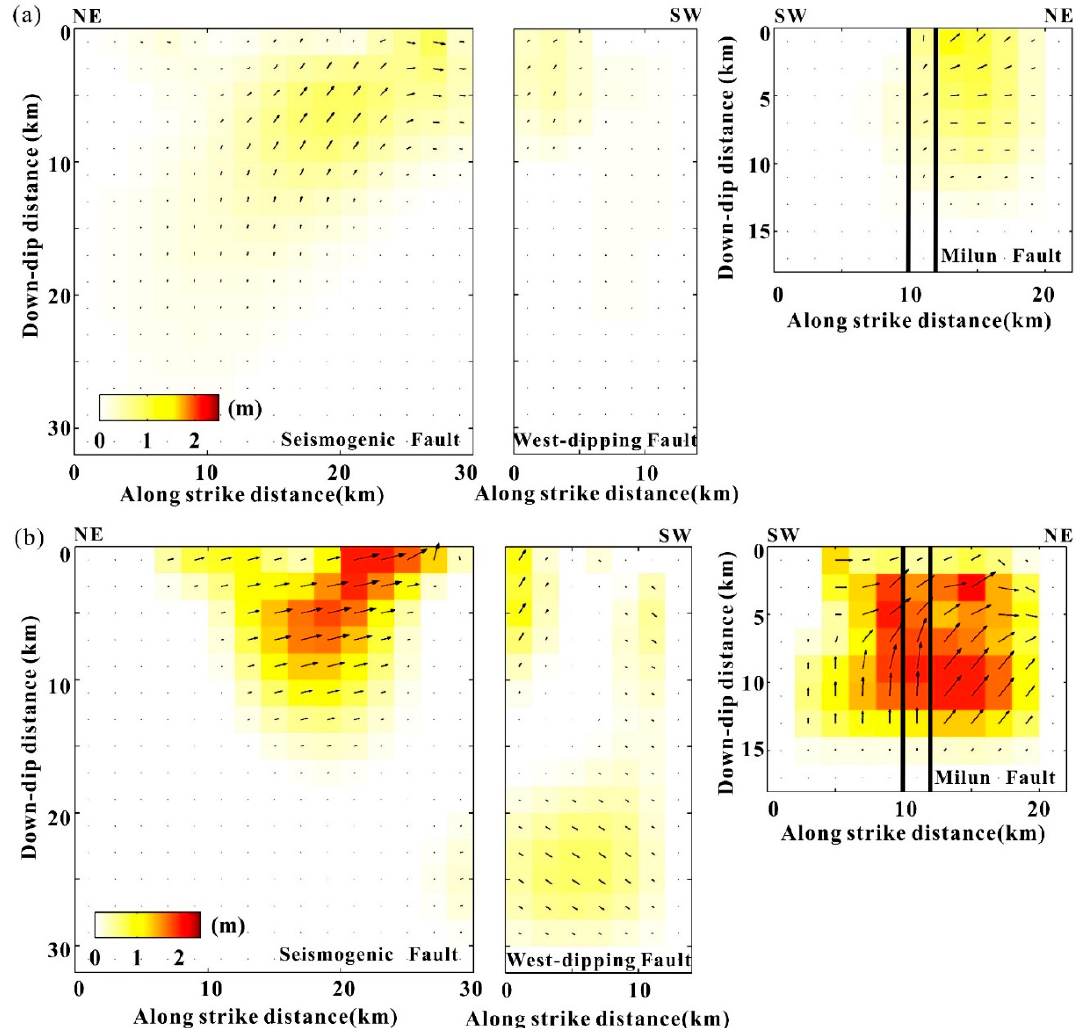
Figure 5. The planar fault slip distributions of the 2018 Mw 6.4 Hualien earthquake. The black lines denote the boundaries of the three segments of the Milun fault. ( a ) The estimated co-seismic fault slip distribution by the GPS data. ( b ) The estimated co-seismic and postseismic fault slip distribution by the four tracks InSAR observations.